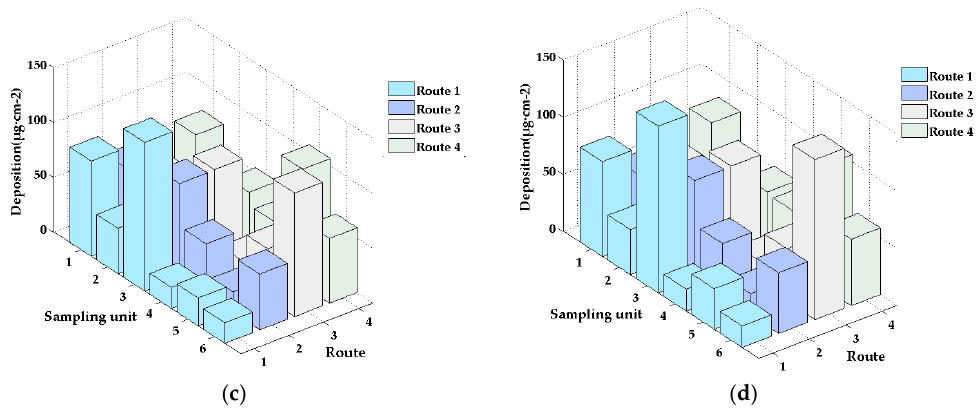
Figure 21. Droplet depositions in various sorties: ( a ) first sortie; ( b ) second sortie; ( c ) third sortie; ( d ) fourth sortie.